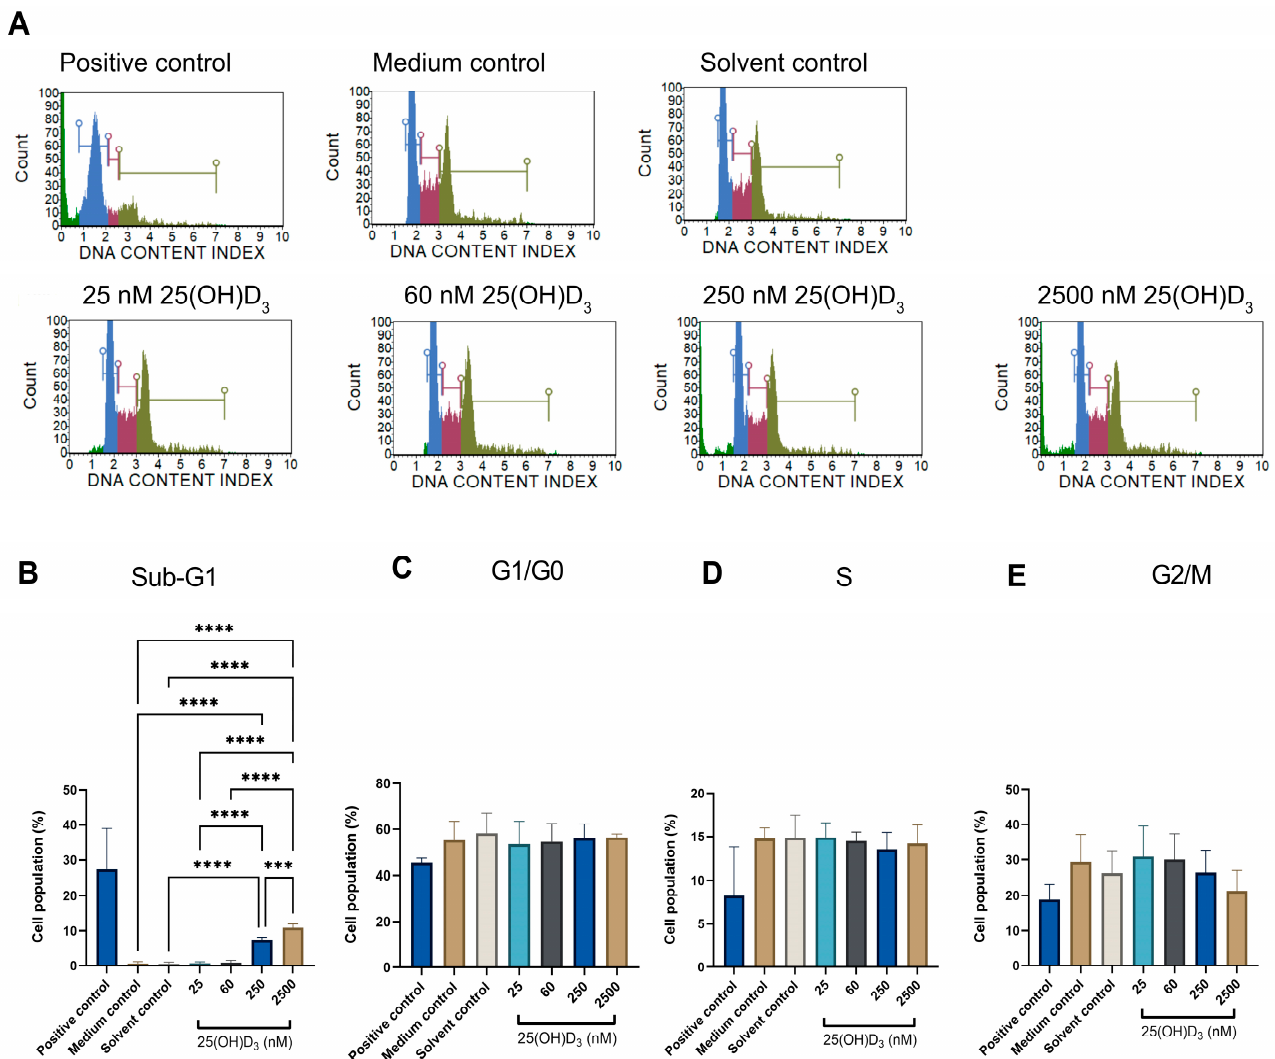
Figure 2. Cell cycle analysis by flow cytometry showing cell cycle histograms of control and experimental SiHa cells ( A ), and statistical analysis of Sub-G1, G1/G0, S and G2/M cell phases (( B – E ), respectively)). The positive control was treated with actinomycin to a final concentration of 0.1 µ g/mL. Data are expressed as mean ( ± SEM) from three independent experiments, each performed in triplicate (*** p ≤ 0.001, **** p ≤ 0.0001).